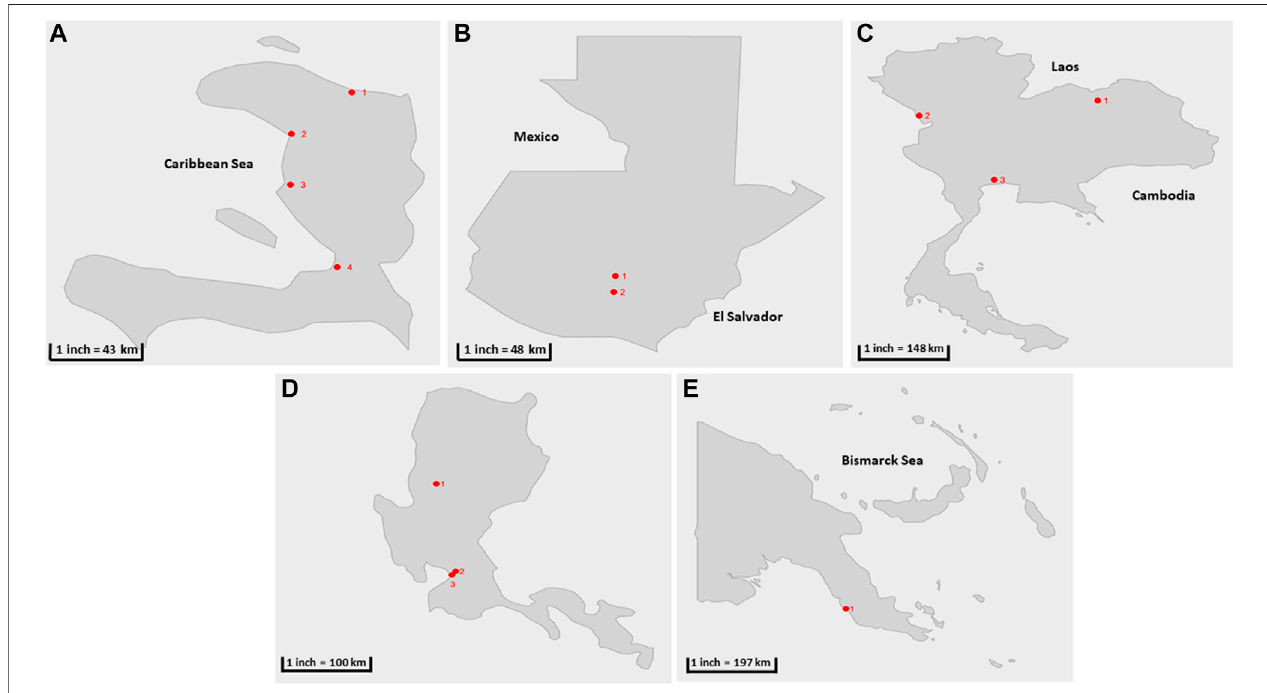
FIGURE1| Geographicallocationofsamplecollectioncitiesduringtheparallelandpilotstudies(showninredcircles) (A) Haïti1)Cap-Haïtien.2)Gonaïves,3)Saint Marc,4)Portauprince (B) Guatemala:1)SanJuanSacatepéquez,2)VillaNueva (C) Thailand1)Udonthani,2)Tak,3)Bangkok. (D) ThePhilippines:1)Baguio,2)Manila, 3) Quezon City. (E) Papua New Guinea: 1) Port